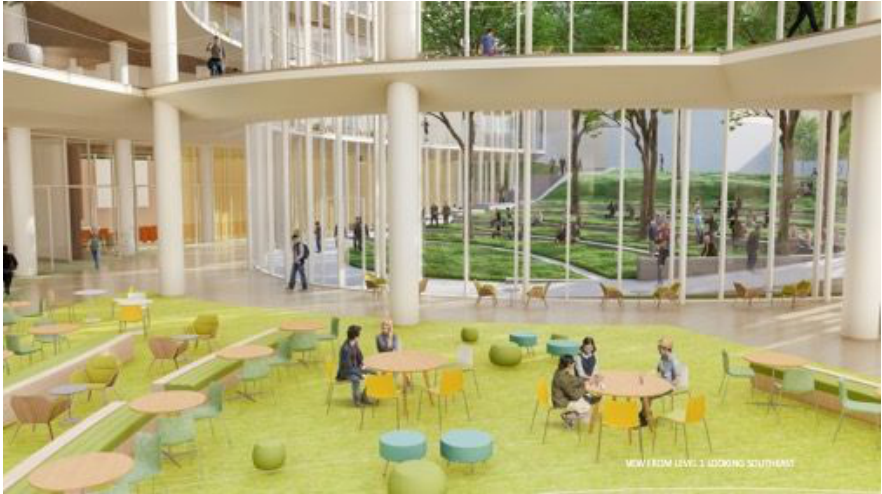
Figure 2. View of gathering spaces for the campus